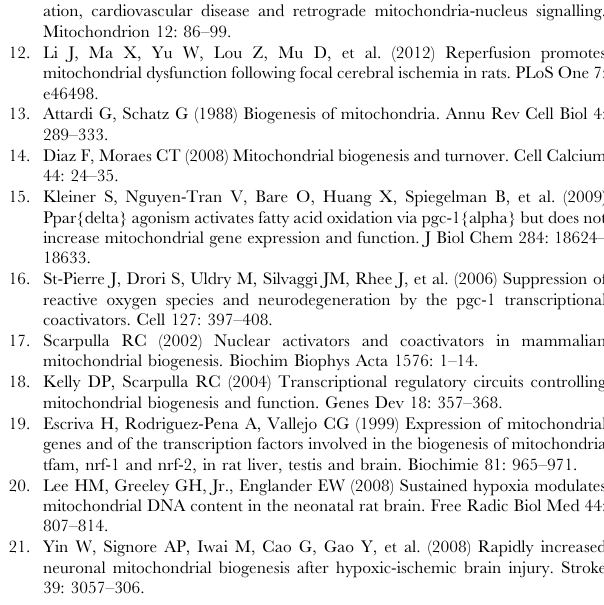
Figure 6. Representative histological characteristics of the cortical brain sections assessed using HE staining. (A and B) The cortical sections from the sham group revealed normal cortical tissue. (C and D) The cortical sections from the I-R 0 h group displayed cortical tissue injury. (E and F) The cortical sections from the I-R 24 h group demonstrated aggravated cortical tissue injury. (G and H) The cortical sections from the I-R 72 h group showed improved residual neurons in the damaged cortex. (I and J) The cortical sections from the I-R 7 d group showed an increased number of cells similar to glial cells in that they appeared round or elongated (arrowheads).